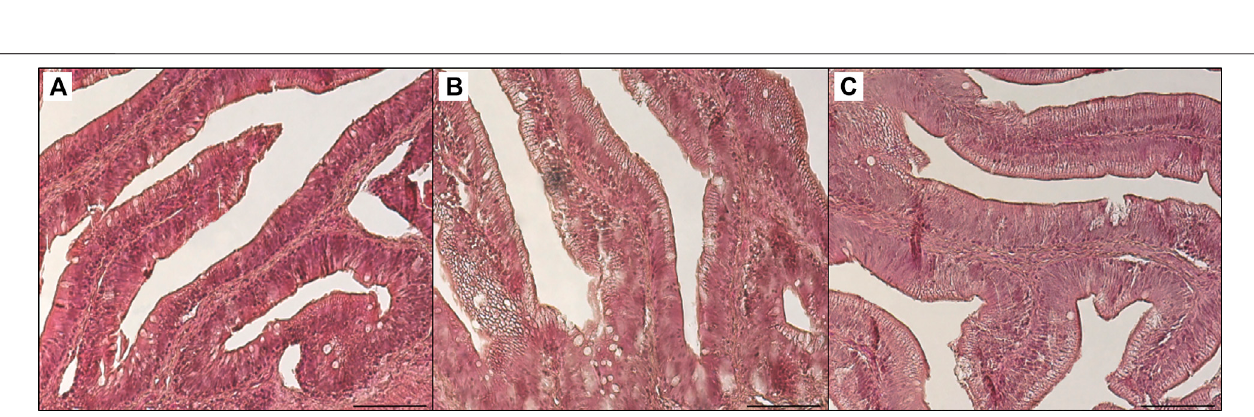
Frontiers in Physiology |